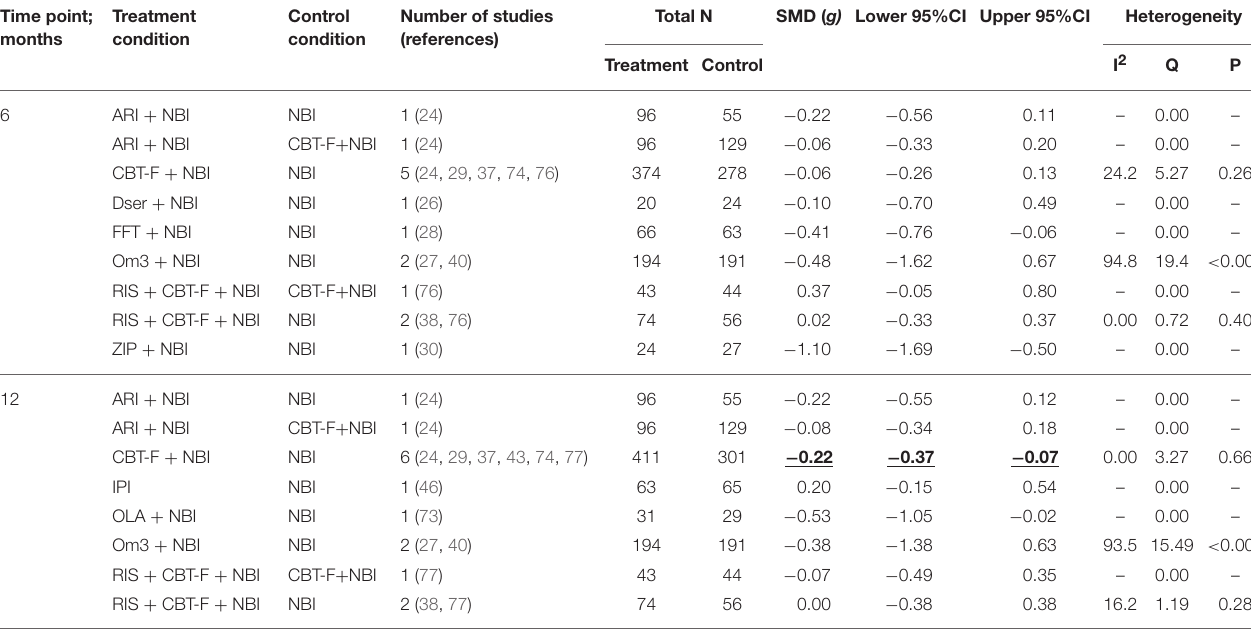
TABLE 2 | Pairwise meta-analytic results for attenuated psychotic symptoms at 6 and 12 months. Time point; Treatment months